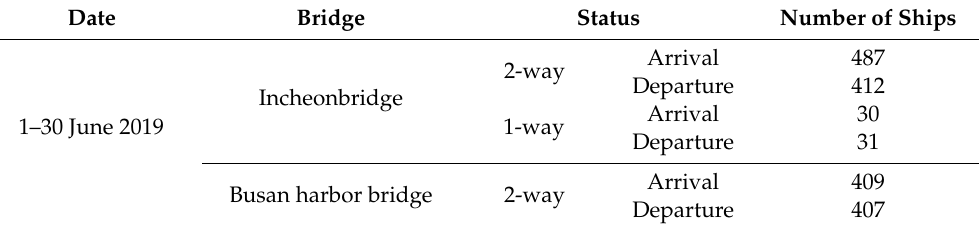
Table 6. Data collection period and the number of ships used during data collection.